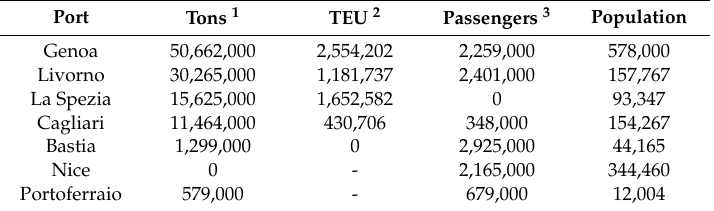
Table 1. Passengers and freight tra ffi c volumes of the biggest ports in the North Tyrrhenian